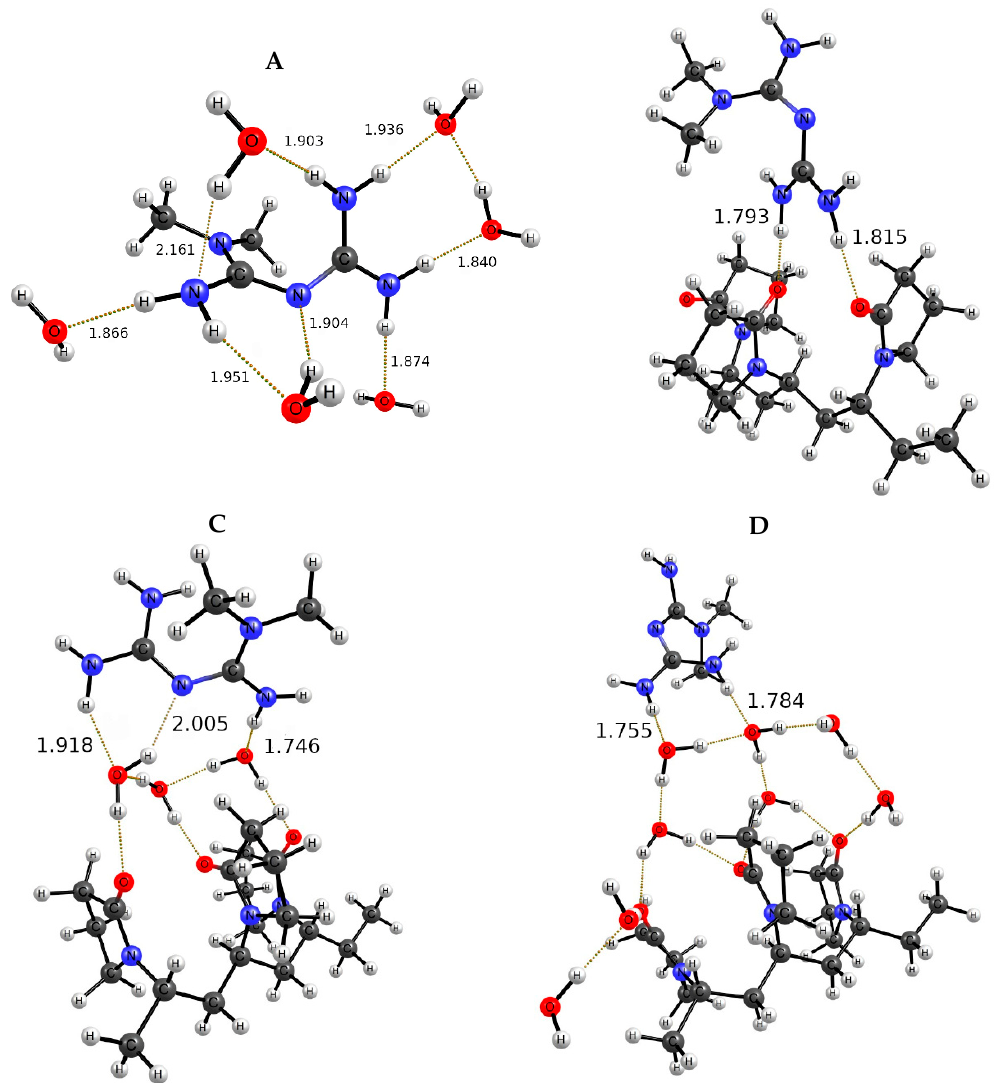
Figure 10. Optimized geometries of MET-copolymer structures: ( A ) MET with 6 water solvation molecules, ( B ) МЕТ associated with С = О groups of the lactam rings of the copolymer, ( C ) МЕТ associated with water molecules of its first hydration shell and ( D ) МЕТ associated with water molecules of its second hydration shell (the distances are given in Angstroms).